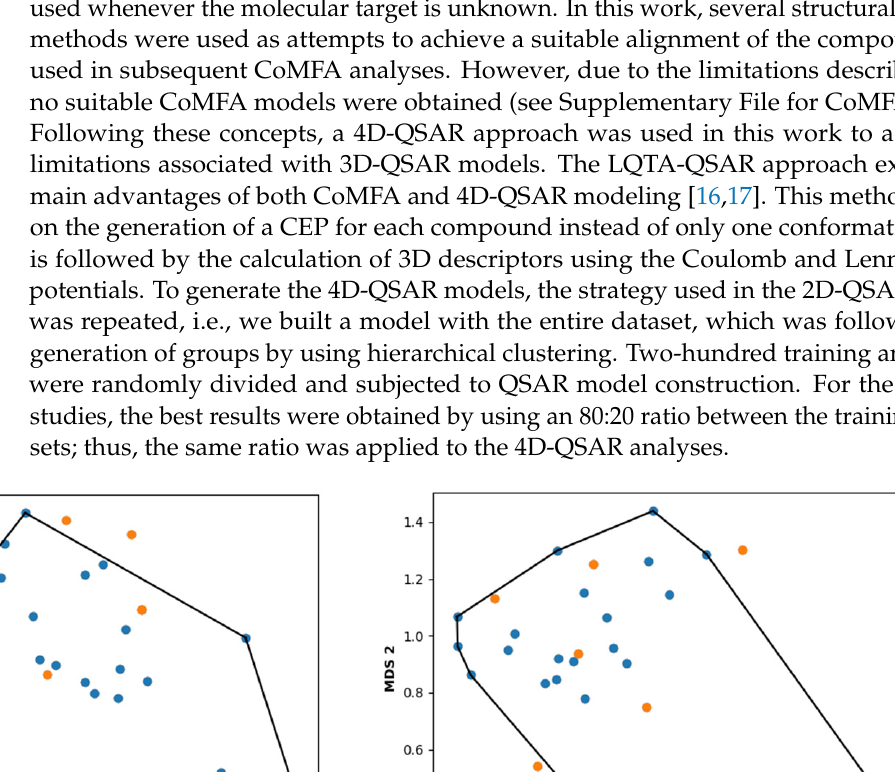
Figure 4. Contribution map generated by KPLS of groups G 1 ( A – D ) and G 2 ( E – H ). Green colors represent positive contributions, and red colors indicate negative contributions to biological activ- ity.